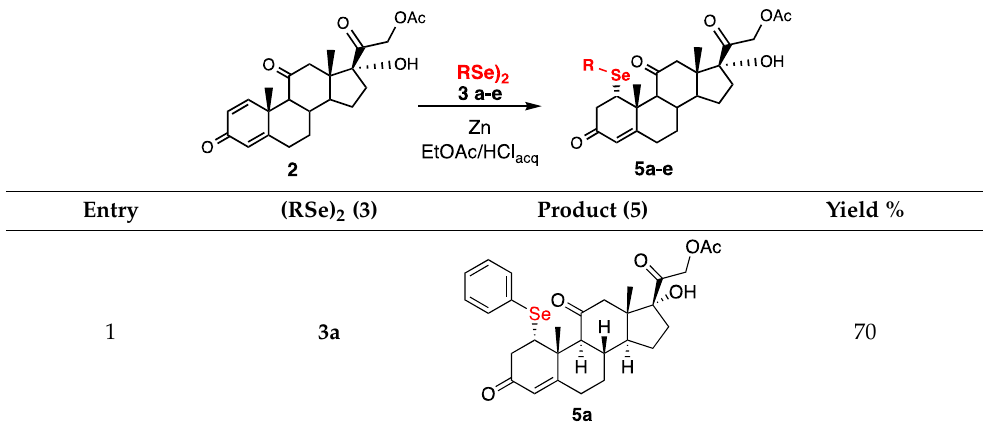
Table 2. Seleno-Michael reactions on substrate ( 2 ).